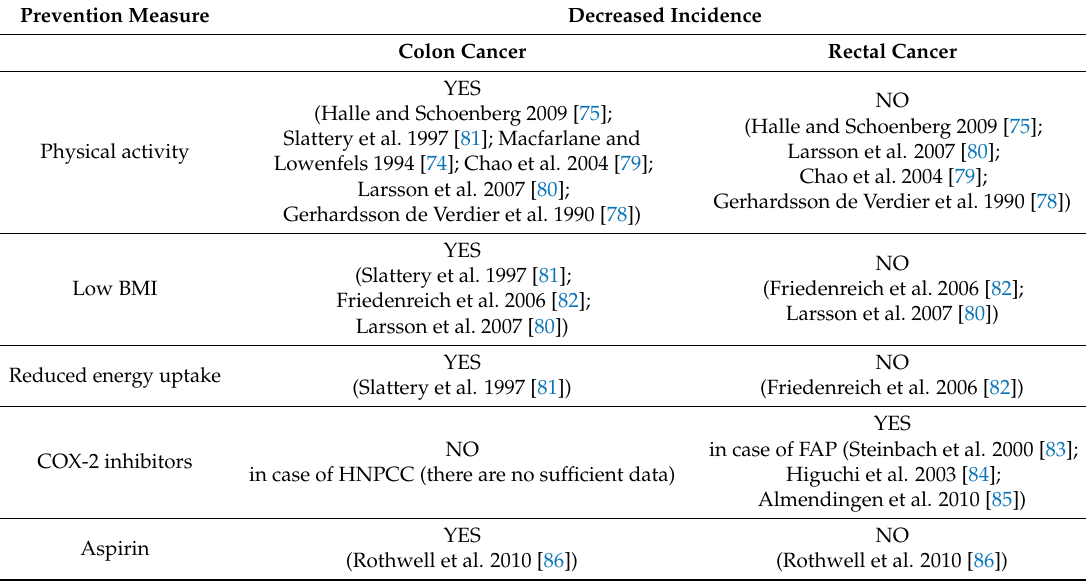
Table 3. Effects of different prevention measures on the two cancer